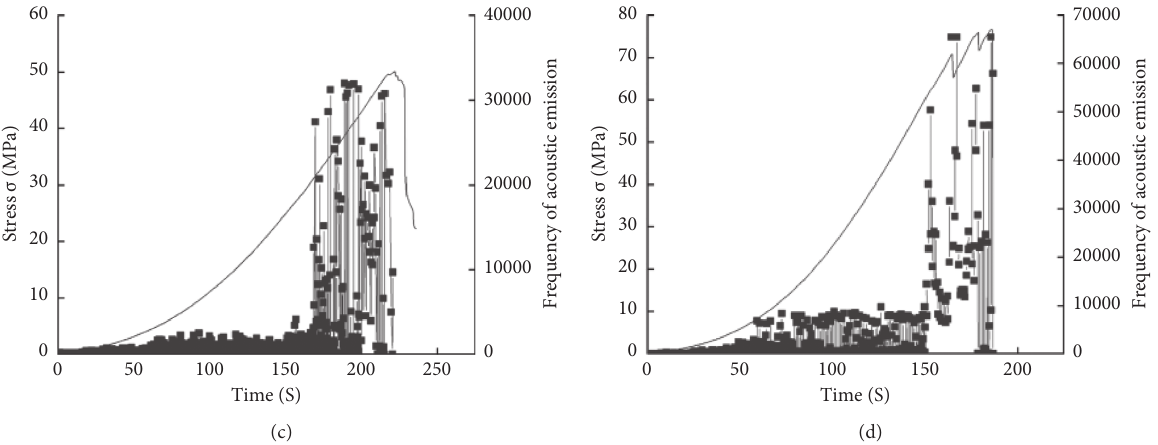
Figure 10: Stress-time-acoustic emission information of the rock sample with the vertical hole of different diameters. (a) Stress- N -time of rock A00. (b) Stress- N -time of rock E05. (c) Stress- N -time of rock F10. (d) Stress- N -time of rock